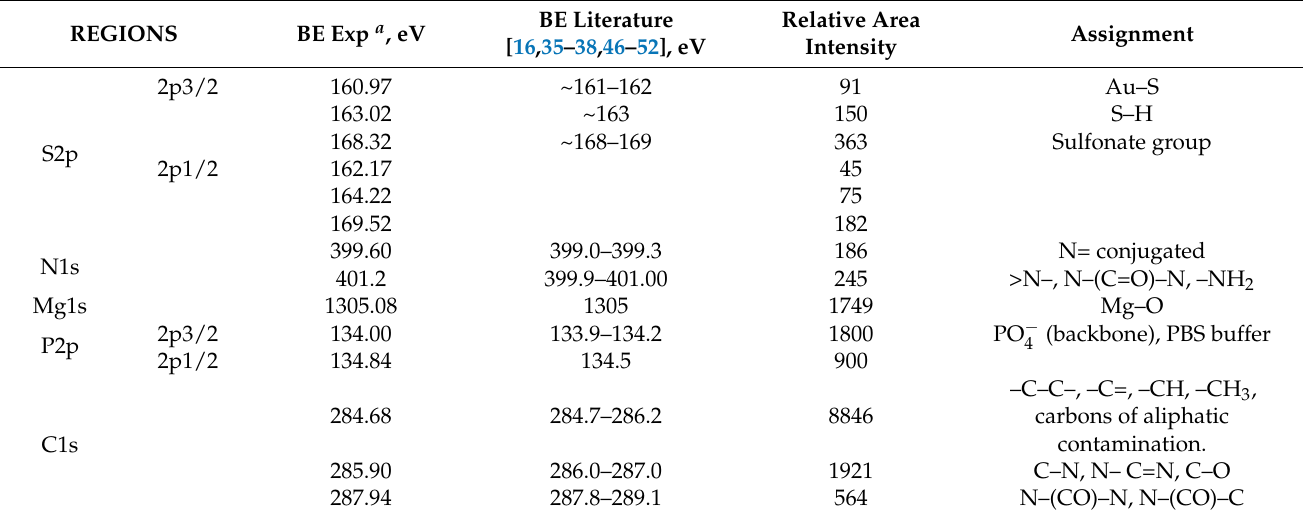
Table 1. Peak fit parameters for five major elements on the absorbed layer in the ssDNA that hybridized the targeted LAMP amplification products and L-cysteine.